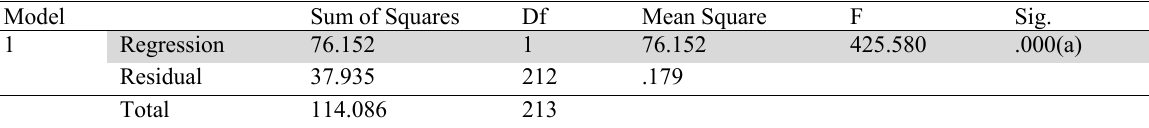
The results of ANOVA (b)